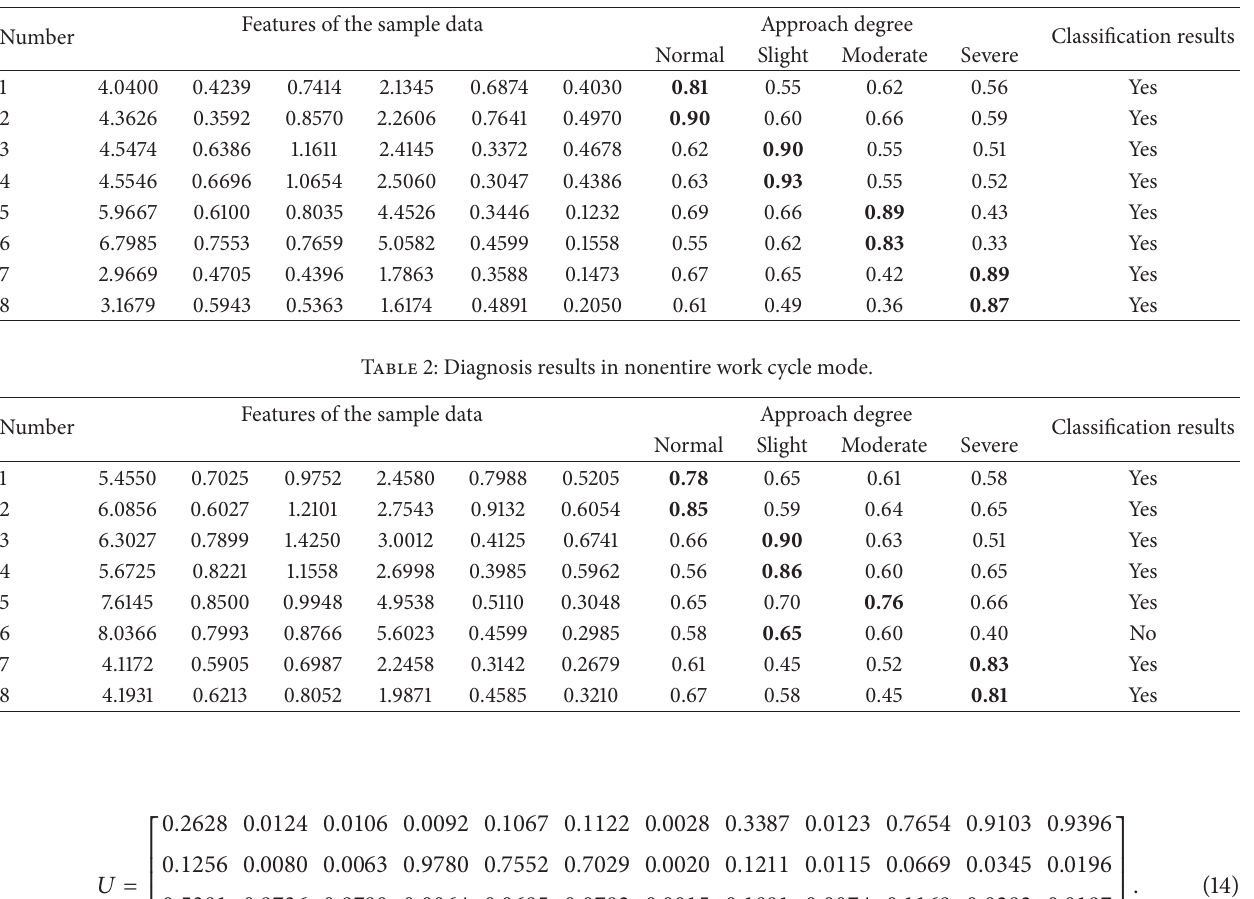
Table 1: Diagnosis results of sample under test.